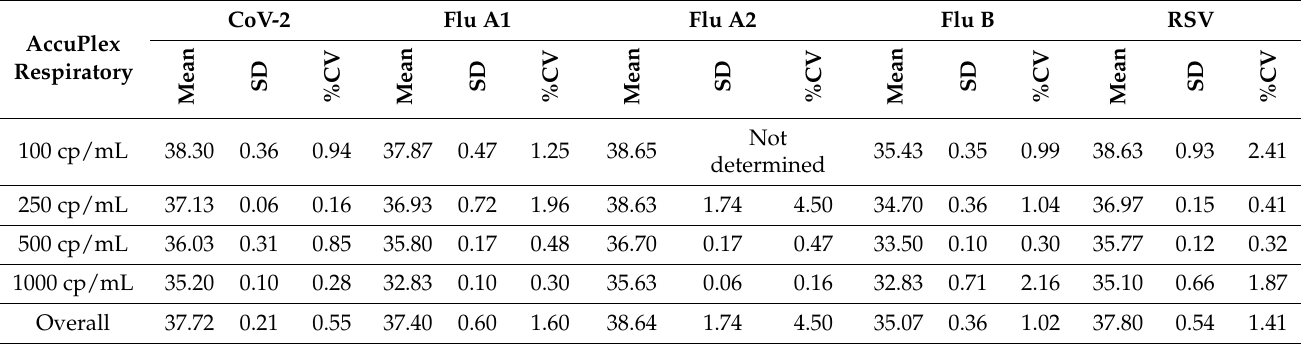
Table 5. Precision of the Xpert ® Xpress CoV-2/Flu/RSV plus